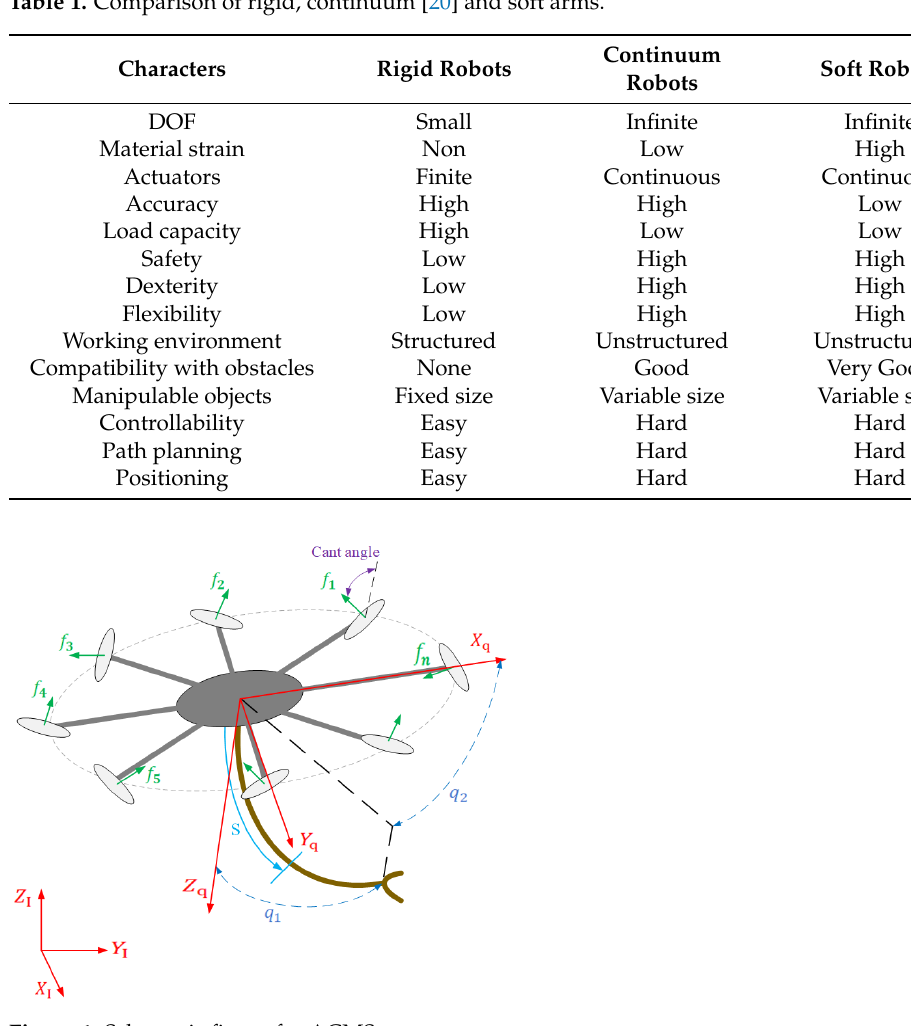
Table 1. Comparison of rigid, continuum [20] and soft arms